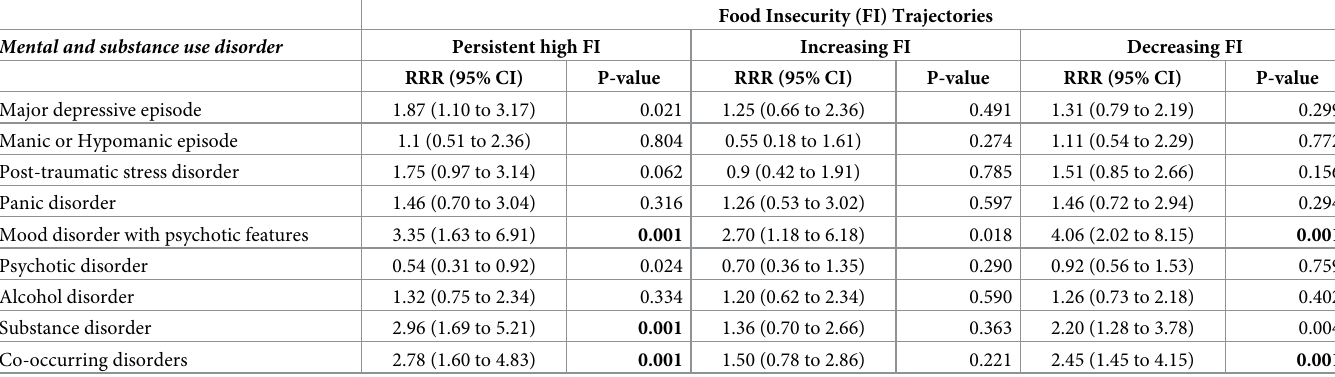
Table 4. Multivariable multinomial logistic regressions Food Insecurity (FI) trajectories and mental disorders adjusted for baseline